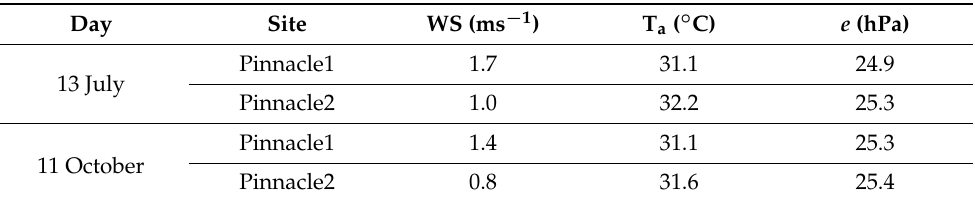
Table 3. Mean midday/afternoon climatic values (11–16 h) registered in Pinnacle1 and Pinnacle2